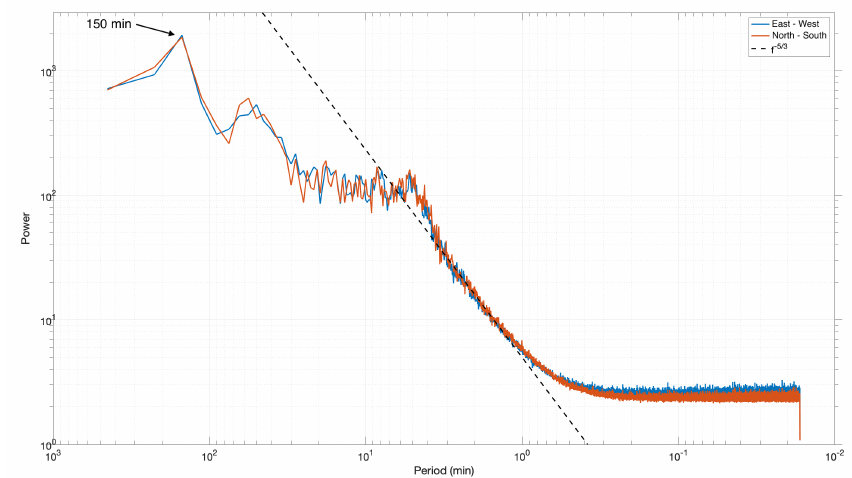
Figure 6. Mean Fourier spectrum of the entire night for the two keograms. The black dashed line is the − 5/3 power law; L is the radiance unit measured on the OH images (ph/s/m 2 /sr). In the Fourier transform of keograms, a peak around the 150 min period is